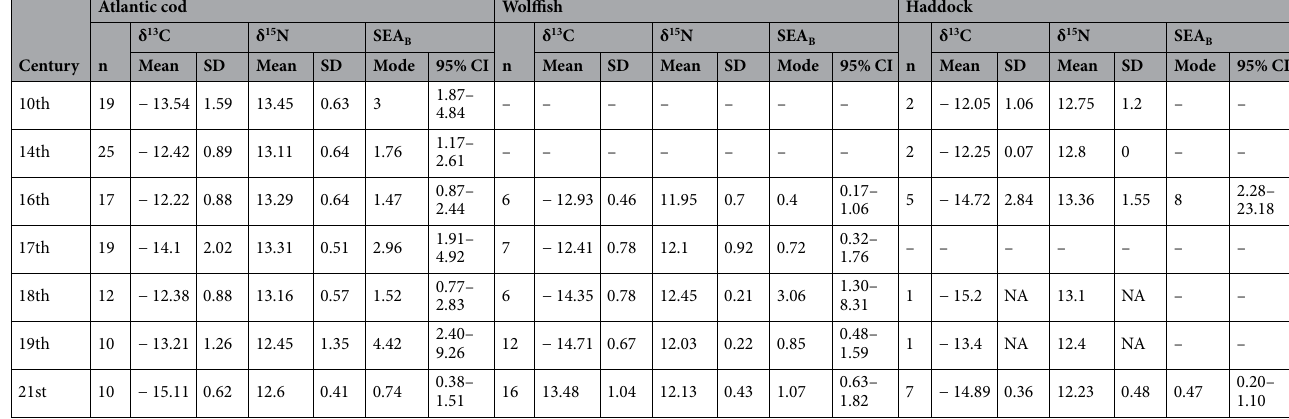
Table 1. Summary information of the zooarchaeological material used for analysis as well as stable isotope ellipse area estimates, SEA B , including 95% confidence intervals (CI) of the SEA B